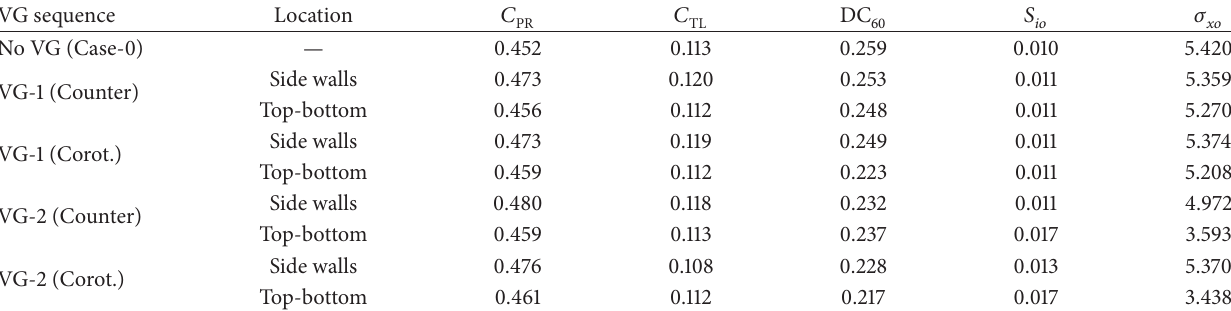
Table 2: Values of performance parameters for all the cases of VG.